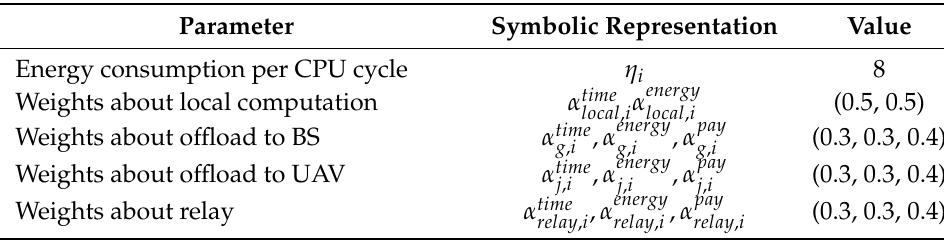
Figure 2. Location distribution in simulation (UAVs’ coordinates are taken from ground projection). Table 1. Other simulation parameter